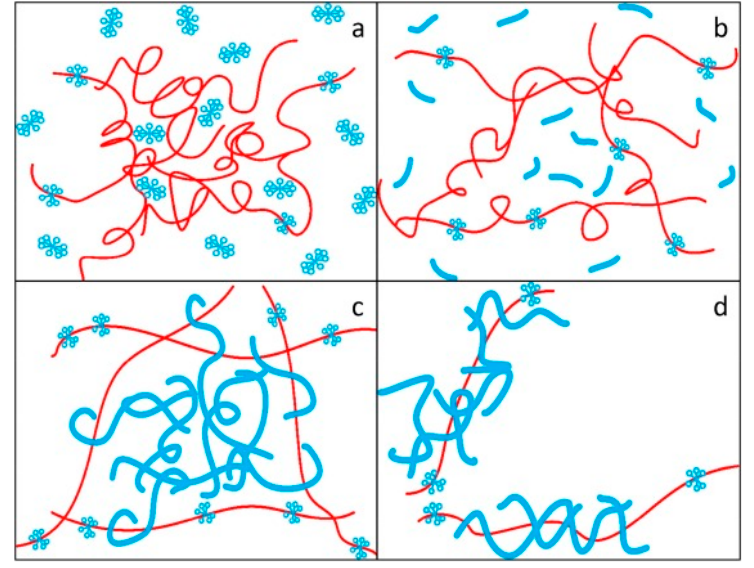
Figure 8. Formation and failure of a complex network structure model: ( a )dispersed polymer molecules and surfactant molecules; ( b ) stretching polymer molecules and rodlike micelles; ( c ) the network structure model of polymer molecules and polymer molecules; ( d ) the broken network structure model [45].